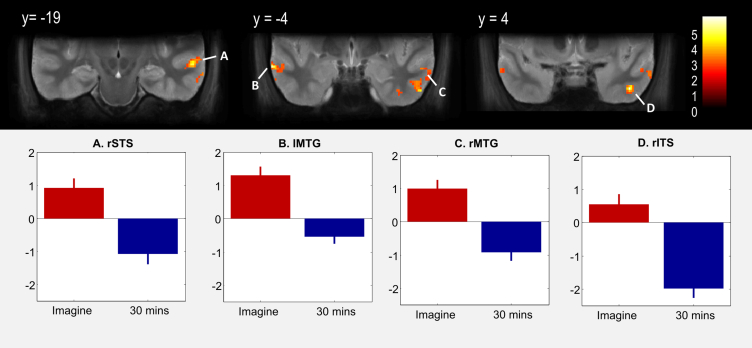
Response to imagining novel scenes relative to 30-min scene recall. SPM whole-volume analysis testing for regions responding more strongly to imagining novel scenes than recalling scenes from 30 min earlier, controlling for object baselines ([Imagine Scenes − Objects] − [30-Minute Scenes − Objects]), i.e., an interaction between stimulus and task. Top. Coronal slices showing clusters of activations in lateral temporal cortex relating to this interaction. Labels correspond to plots below. Images thresholded at p < .05 FDR-corrected, overlaid on the group average T2 structural volume. Bottom. Parameter estimates averaged over voxels in the corresponding clusters, describing the interaction in each region. Red bars show imagining novel scenes ([Imagine Scenes − Objects]) and blue bars show 30-min scene recall ([30-Minute Scenes − Objects]). Positive values indicate a stronger response to scenes than object baselines. ±1 SEM. Similar results pertained when 1-week scene recall was compared to 30-min scene recall (see Fig. S2). rSTS = right superior temporal sulcus, lMTG = left middle temporal gyrus, rMTG = right middle temporal gyrus, rITS = right inferior temporal sulcus.